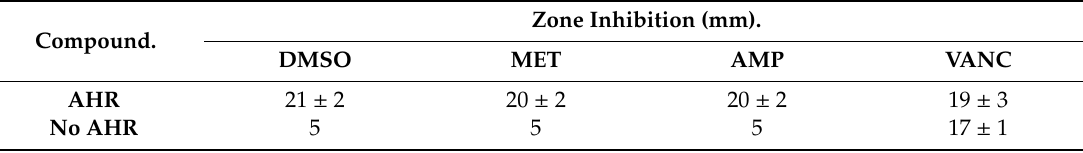
Table 2. Synergy e ff ect of AHR and three di ff erent antibiotics against the